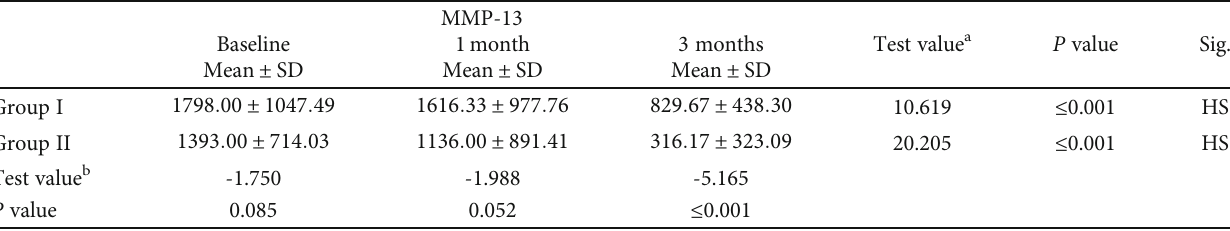
Table 3: The change in mean MMP-13 conc. at di ff erent